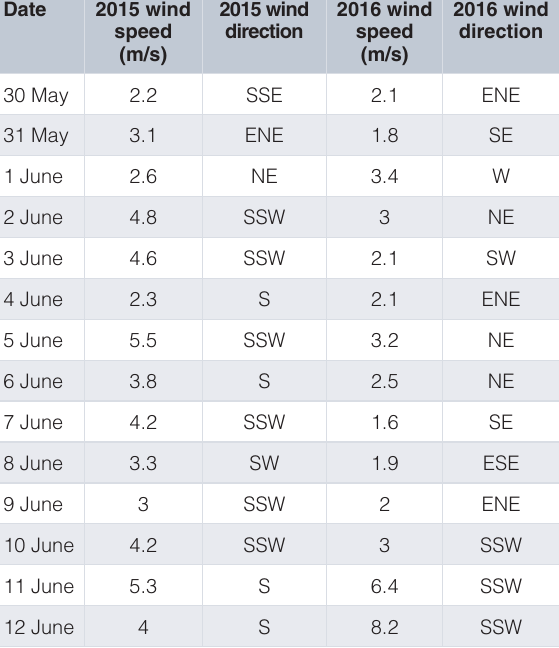
Table 2. Mean daily wind speeds in the 12 days prior to the first observations of bleaching on 12 June 2016 and for the same dates in 2015. Data from Japan Meteorological Agency.